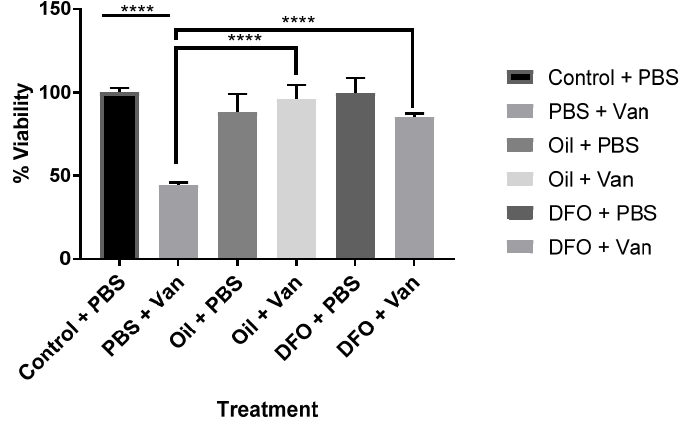
Figure 1. Dose response to vanadium on oxidative stress (mitochondrial viability) in undifferentiated and differentiated Catecholaminergic a-differentiated (CAD) cells ( A ), and the iron content in undifferentiated and differentiated CAD cells ( B ). Results from the mitochondrial viability investigation showed that undifferentiated neuronal cells ( A ) are more sensitive (ca. 10-fold) to vanadium than differentiated cells ( B ). This correlates with the significantly higher ( p < 0.005) levels of intracellular iron in undifferentiated versus differentiated CAD cells. Values are mean ± SD for n = 4 replicates for the mitochondrial viability assay, and for the metal content analysis, values are mean ± SD from 2 separate experiments and n = 4 for each individual experiment (Student’s t -test ** p < 0.005). The effects of both synthetic (DFO) and natural iron chelators ( Aloysia citrodora essential oil) upon vanadium (200 μ M)-induced oxidative stress (mitochondrial viability) following chronic (six-day) exposure in differentiating CAD cells was investigated. Both DFO and A. citrodora oil significantly reversed vanadium-induced toxicity, as compared with vanadium-only treated cells (Figure 2).